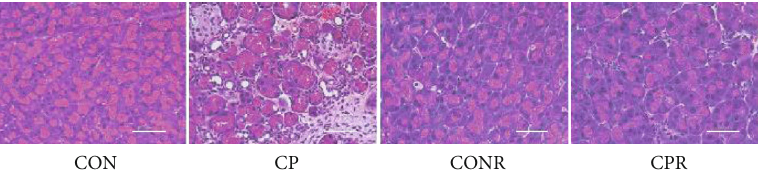
Figure 1: Cerulein-induced CP and the recovery mouse model. Adult C57BL/6 mice, both female and male, received cerulein injections (50 μ g/kg, ip, 5 hourly injections/day, 3 days/week) for 4 weeks for CP injury, followed by cessation of cerulein injections for 4 weeks for recovery period (CPR). Time-matched control mice received normal saline injections (CON and CONR). Pancreatic tissue sections were prepared for H&E staining and scored for CP injury as described [10]. Representative images of female mice of CON, CP, CONR, and CPR are shown. Scale bar =50 μ